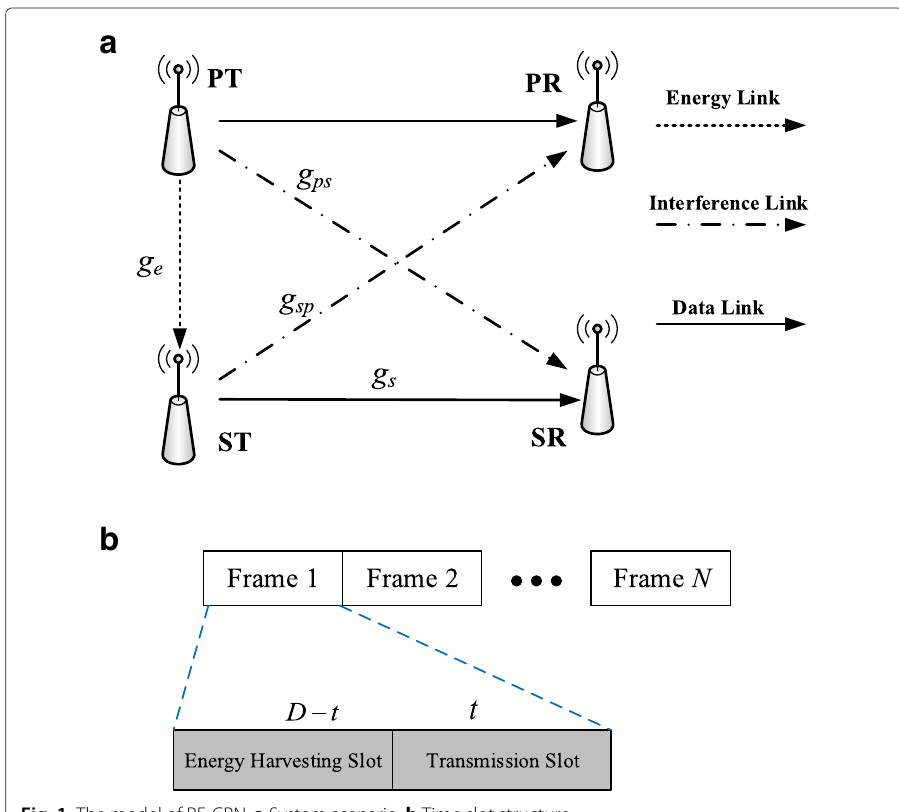
Fig. 1 The model of RF-CRN. a System scenario. b Time slot